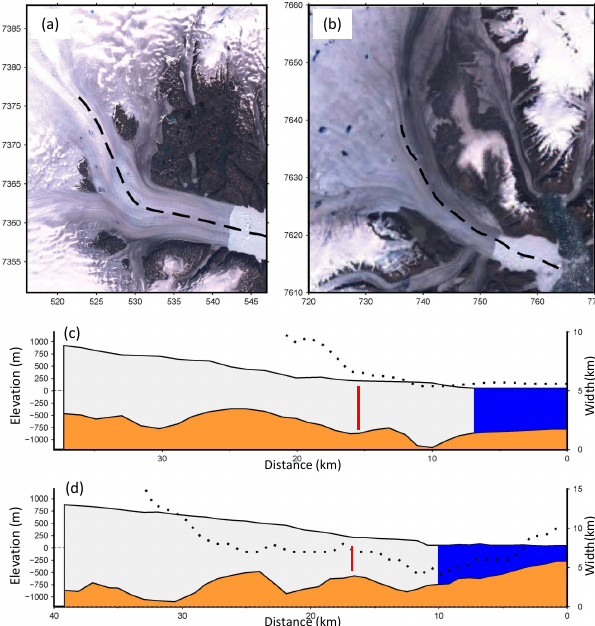
Figure 11. (a) : Landsat7 ETM+ “true color” image of Helheim Glacier from 2 August 2001; (b) : Landsat7 ETM+ “true color” im- age of Kangerdlugssuaq Glacier from 6 August 1999; (c) : Bedrock and ice surface profiles along the dashed line shown in (a) . The dot- ted curve represents width of Helheim Glacier along the same pro- file. The vertical red line denotes minimum retreat of the Helheim Glacier (which occurred in 2005, see Fig. 8). (d) : Same as (c) but for Kangerdlugssuaq Glacier. The minimum retreat of the Kangerd- lugssuaq Glacier occurred in 2012 (see Fig. 9). Bed data is obtained from Bamber et al.